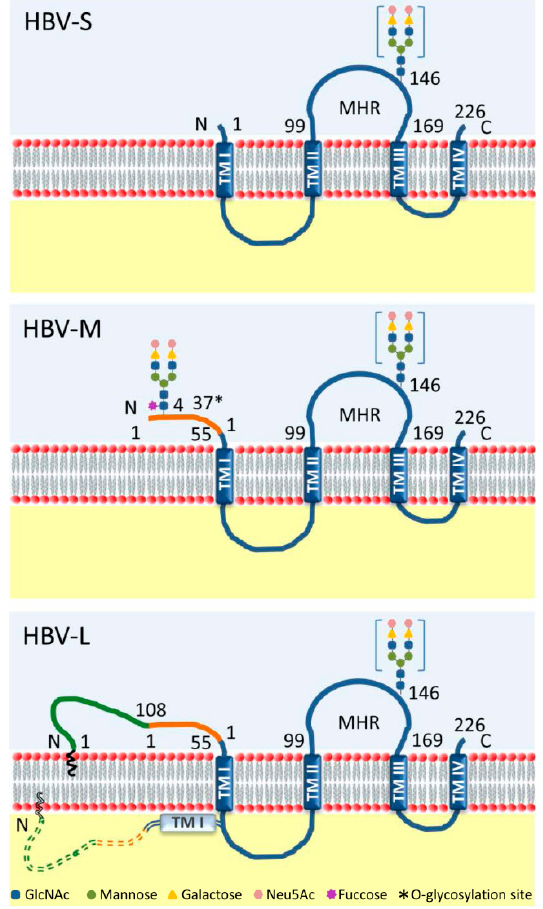
Figure 1. Schematic representation of the Hepatitis B Virus (HBV) envelope glycoproteins. S, M and L proteins contain four transmembrane domains (TM I-IV) and share a common S domain (blue). HBV-M is extended with the preS2 domain (orange) at the N-terminus, while HBV-L has an additional pre-S1 domain (green). HBV-L is characterized by a dual topology of the pre-S region, facing either the ER lumen (solid line) or the cytosol (dashed line). The two functional N-glycosylation sites are indicated: N4 in the preS2 region, occupied only in HBV-M; and N146 in the major hydrophilic region (MHR) of the S domain, occupied in half (in square brackets) of all three proteins [6]. The complex structure of the N-glycans is represented [10,11]. The O-glycosylation site identified in the preS2 domain of HBV-M is also shown (*)